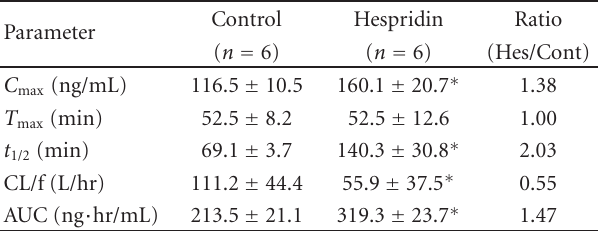
Table 2: E ff ect of hesperidin on the pharmacokinetic parameters of single-orally administrated pravastatin on rats.